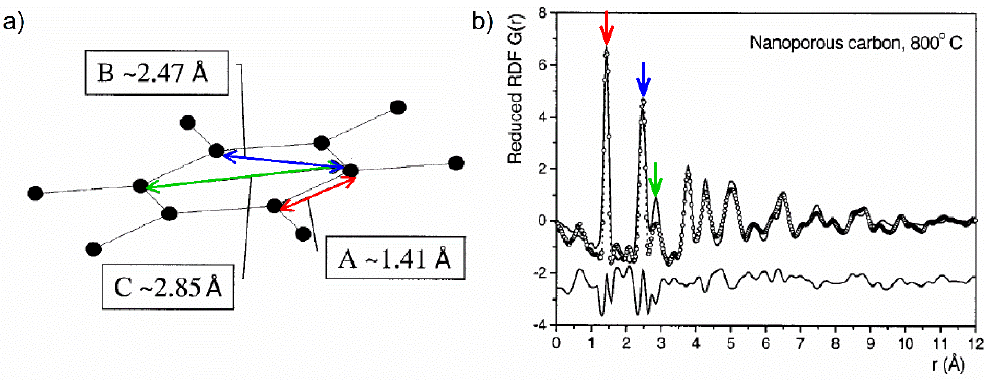
Figure 19. ( a ) C–C bond distances in an aromatic-type hexagonal ring of graphite structure. ( b ) Comparison of the experimental pair distribution function for the glassy carbon pyrolysed at 800 °C (dotted line) with the calculated pair distribution function for a slightly-curved graphene-type model optimized by Petkov et al. [83]. Reproduced with permission from Petkov et al. [83]. Copyright Taylor and Francis, 1999.